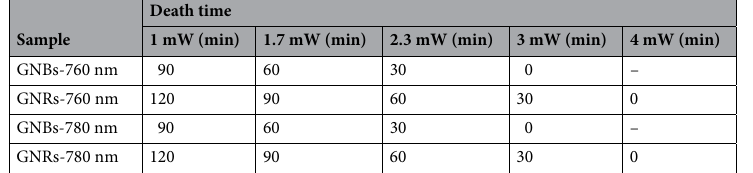
Table 3. Summary of the information about the fs laser power and cell death